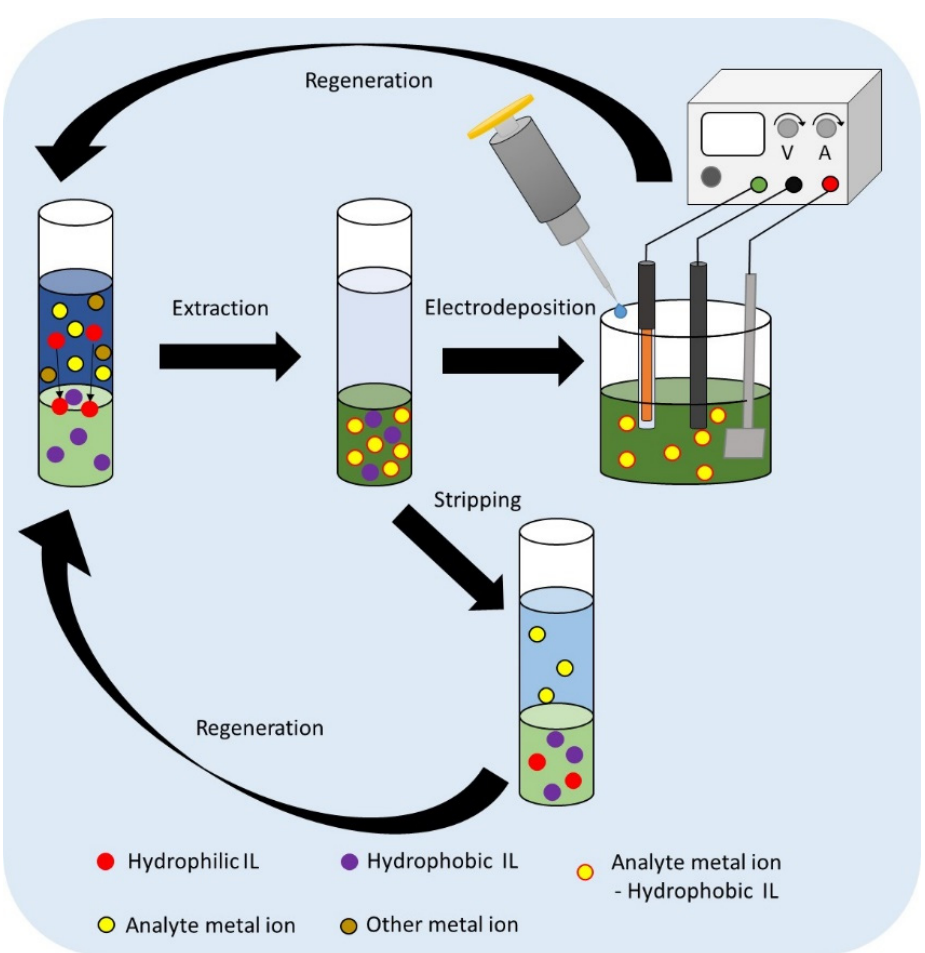
Figure 5. Metal extraction–electrodeposition process (with stripping) in hydrophilic and hydrophobic ILs.